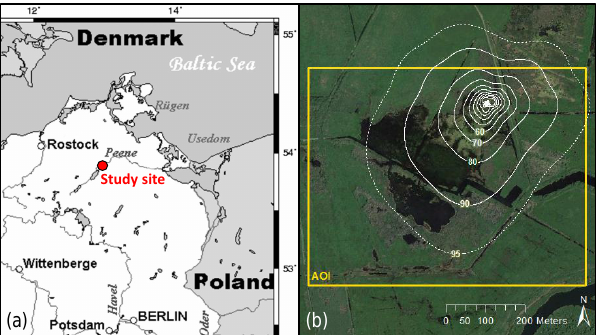
Figure 1. (a) Polder Zarnekow is situated in NE Germany within the Peene river valley; map source and copyright: https://commons. wikimedia.org/wiki/File:Germanymap2.png (modified). (b) Foot- print climatology calculated according to Chen et al. (2011) on a Landsat image (6 June 2013, source: Google Earth). White lines represent the isopleths of the cumulative annual footprint climatol- ogy, where the area within the 95 isopleth indicates 95% contribu- tion to the annual flux. The white dot denotes the tower position. The yellow box indicates the area of interest (AOI) as a filter crite- rion to focus on fluxes of the shallow lake and to avoid the possible impact of a farm and grassland to the north of the shallow lake. If the half-hourly flux source area exceeded the AOI by more than 20% the flux was discarded. The site is characterised by two main surface types: open water and emergent